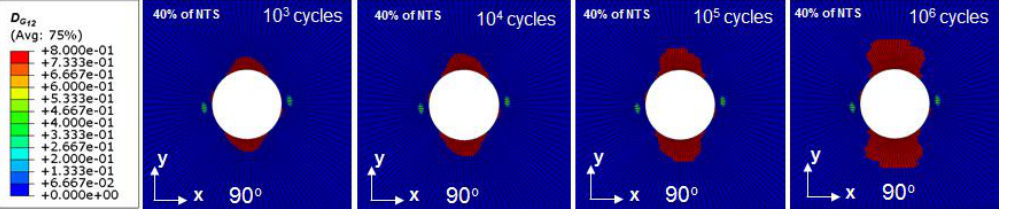
Figure 20 . Reduction in stiffness G 12 in 90° plies of the OHT specimen for increasing fatigue cycles.